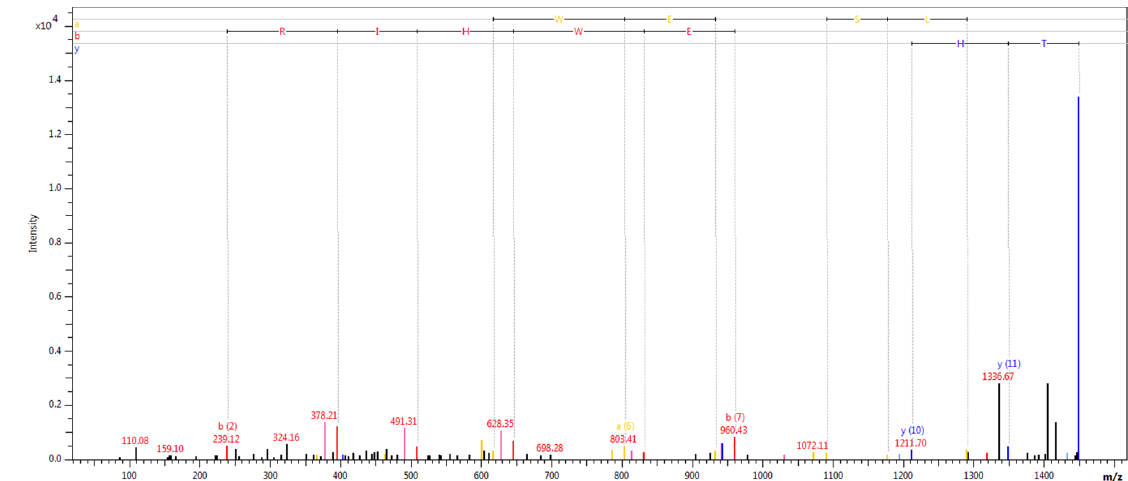
Figure 2. Fragmentation spectrum of peak 1449.61, identified as complement C4A .